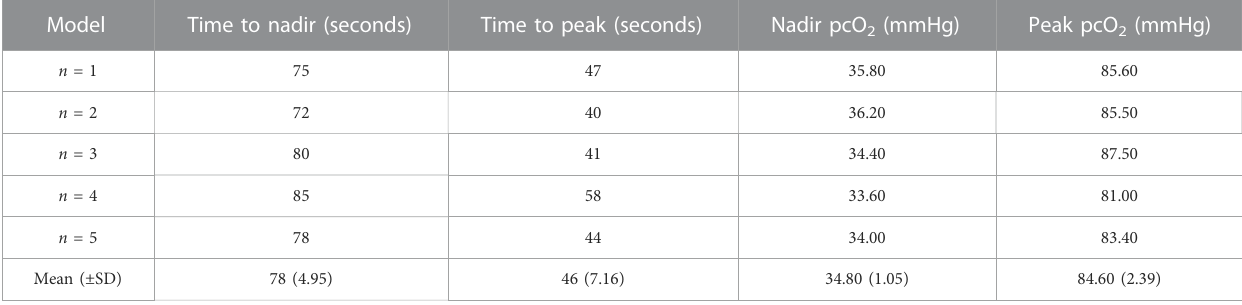
TABLE 2 Hypoxic cycle characteristics reached in the model.